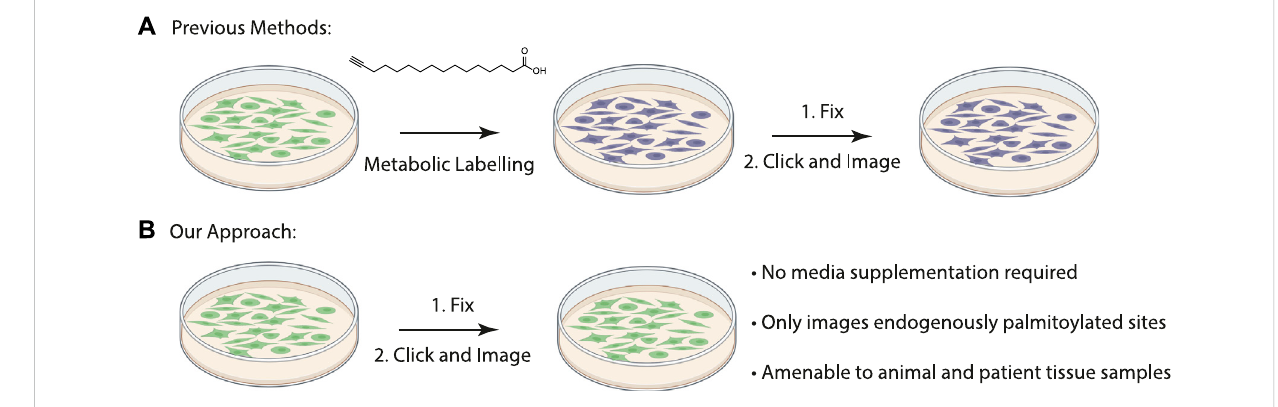
FIGURE 1 (A) Schematic of previously described procedure for visualizing palmitoylated proteins by metabolic labeling of cultured cells with palmitic acid alkyne. (B) New method to visualize palmitoylated proteins without metabolic